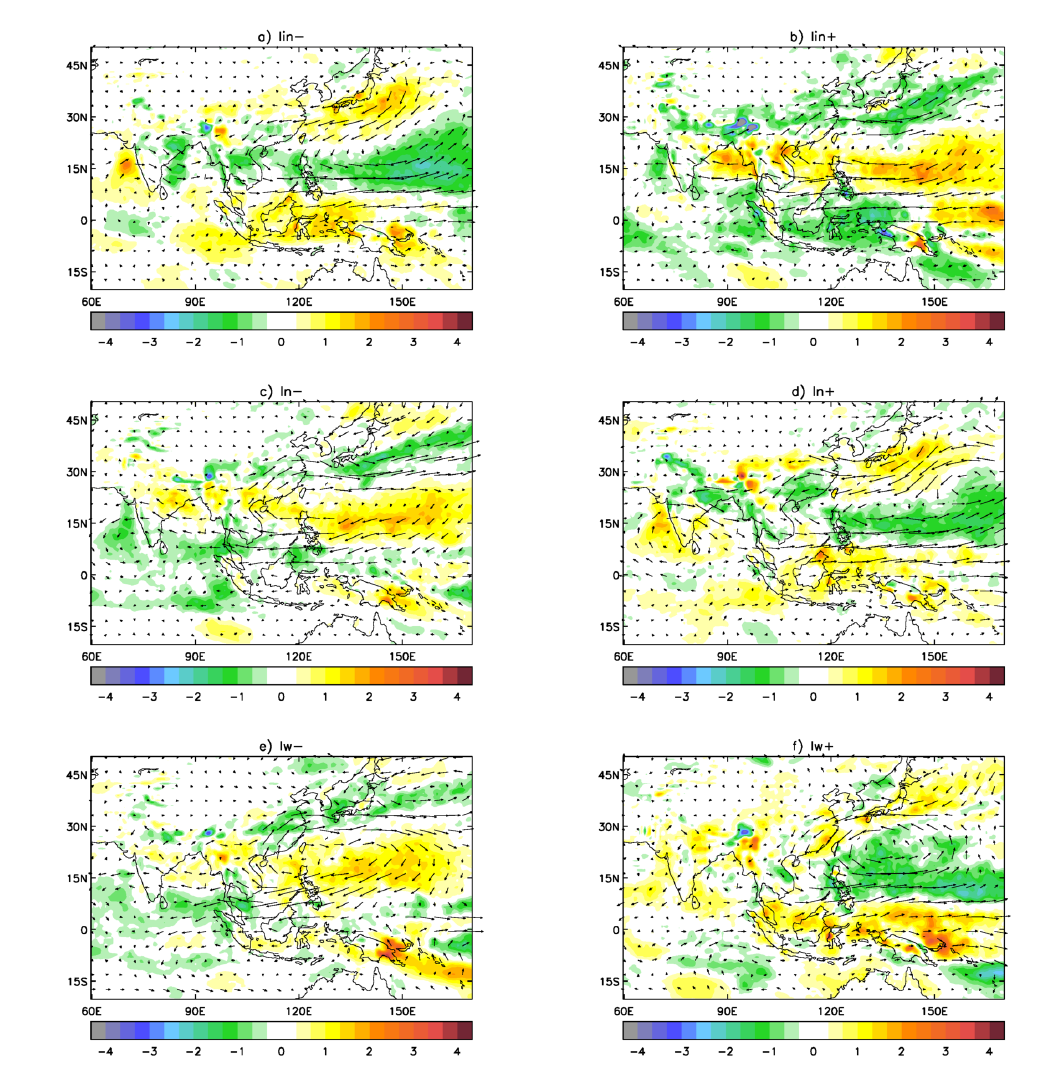
Figure 6. ERA-I June–August anomalous (composite—1982–2007 mean) water vapour divergence (shaded, 10 5 Kgm 2 s − 1 ) and anomalous water vapour flux transport (arrows) for composites associated with WPSH indices: I IN ( a , b ); I N ( c , d ) and I W ( e , f